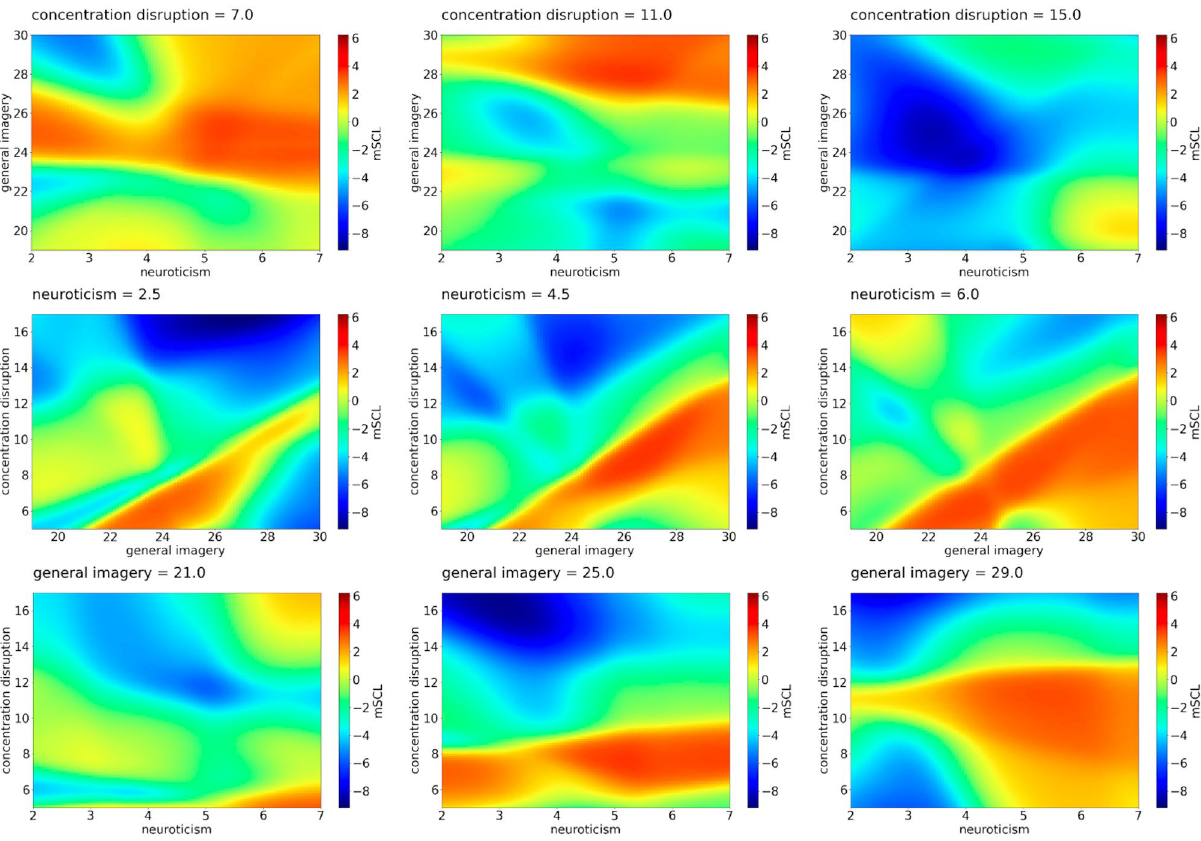
Figure 2. mSCL as a function of psychological features—example predictions of Model 2. First row: mSCL as a function of general imagery and neuroticism for three values of concentration disruption . Second row: mSCL as a function of general imagery and concentration disruption for three values of neuroticism . Third row: mSCL as a function of concentration disruption and neuroticism for three values of general imagery . Three chosen values of concentration disruption, neuroticism, and general imagery represent the middle points of each tercile of these